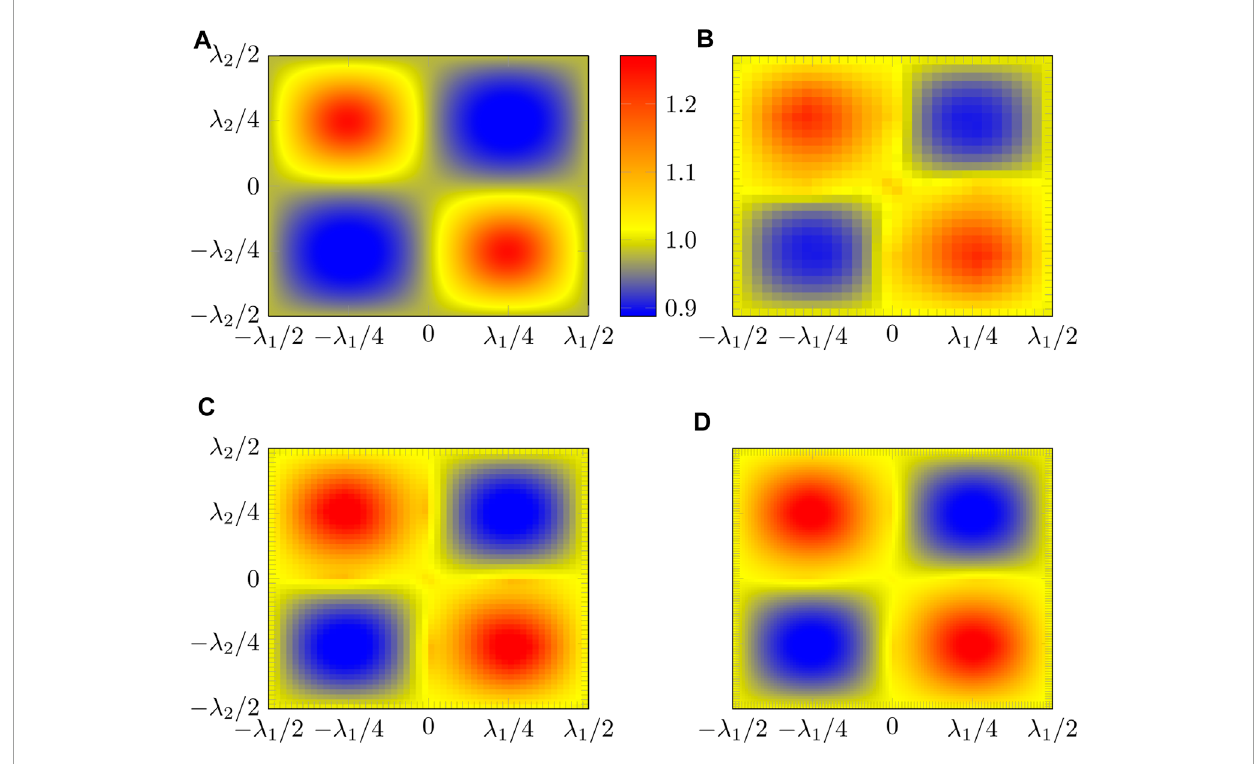
FIGURE 3 Strain concentration field A iiii ( x ) , i = 1 , 2 , 3, arising from the sinusoidal microelasticity distribution of Eq. 50 , at the plane x i = λ i / 4, i = 1 , 2 , 3, obtained (A) analytically from Eq. 123 , and numerically by means of FFT (Lucarini et al., 2021) with (B) 32 3 voxels, (C) 52 3 voxels, and (D) 100 3